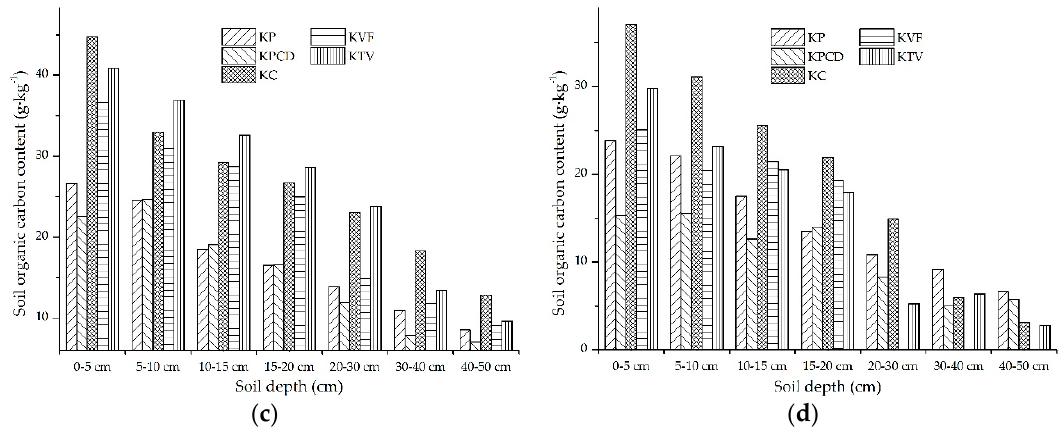
Figure 5. The spatial distribution characteristics of soil organic carbon (SOC) under different vegetation types: ( a ) shows the SOC content in topsoil under different vegetation; ( b ), ( c ) and ( d ) represent the SOC content in topsoil in different karst landforms under evergreen forest, deciduous forest and meadows, respectively.